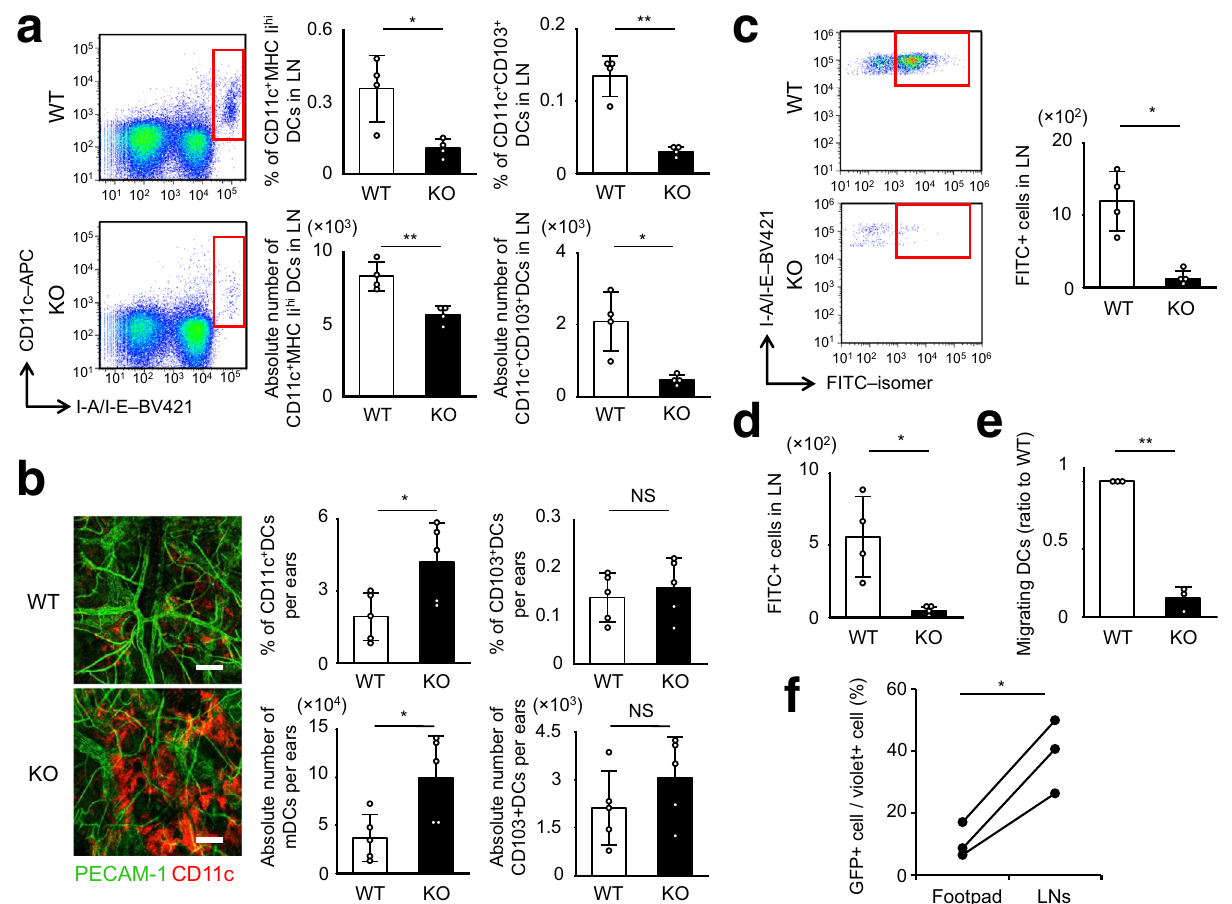
Fig. 8 Impaired in vivo DC traf fi cking in DC-speci fi c Lamtor1 − / − mice. a Migratory DC subset in inguinal LNs. Single-cell suspension from inguinal LNs was stained for CD11c and MHC II, and migratory DCs (red rectangle) were counted by fl ow cytometry (left). Population (upper) and absolute number (lower) of CD11c + MHC II hi DCs (middle), and CD11c + CD103 + DCs (right) of WT (white bar) and CD11c – Lamtor1 fl ox/ fl ox (black bar) mice are shown. b Dermal DCs in the ears. Ears from WT (upper) and CD11c – Lamtor1 fl ox/ fl ox (lower) mice were split, fi xed in 4% paraformaldehyde, stained with anti- PECAM (green) and anti-CD11c (Red), and observed by confocal microscopy. Scale bar, 100 μ m (left). Percentage (upper) and absolute number (lower) of CD45 + CD11c + dermal DCs (middle) and CD11c + CD103 + dermal DCs (right) in WT (white bar) and CD11c – Lamtor1 fl ox/ fl ox (black bar) ears, as determined by fl ow cytometry (right). c The number of fl uorescein isothiocyanate (FITC)-positive DCs in draining LNs in WT (white bar) and CD11c – Lamtor1 fl ox/ fl ox (black bar) mice. Forty-eight hours after FITC-sensitization on the ear, cells isolated from cervical LNs were stained for CD11c and MHC II. FITC + DCs were evaluated by FACS (red rectangle, left) and counted (right). d Number of FITC-bead – bearing DCs in popliteal LNs. Forty-eight hours after FITC-bead injection into the footpads of WT (white bar) and CD11c – Lamtor1 fl ox/ fl ox (black bar) mice, cells were isolated from popliteal LNs, stained for CD11c and MHC II, and analyzed by FACS. FITC + DCs were counted. e Comparison of DCs arriving in LNs after footpad administration. CFSE-labeled WT (white bar) and Lamtor1 − / − (black bar) DCs were adoptively injected into the right and left footpads of WT recipient mice, respectively. Single cells were isolated from popliteal LNs 48 h after injection, and CFSE + cells were counted. The ratio of the number of fl uorescein-labeled DCs was calculated relative to WT. f In vivo DC-traf fi cking of Lamtor1 − / − DCs in which Lamtor1 expression was restored. Lamtor1 -IRES-GFP vector was introduced into Lamtor1 − / − BMDCs using a lentivirus system, and the cells were stained with cell tracer violet. The violet-labeled DCs were injected into the footpad of WT mice, and cells were isolated from popliteal LNs. The ratio of GFP + DCs (Lamtor1-restored DCs) to violet + DCs (lentivirus-treated DCs including Lamtor1-restored and -not restored DCs) in popliteal LNs was determined by FACS. Data were pooled from four ( a – d ) or three ( e , f ) independent experiments. Statistical analysis was performed by two-sided Student ’ s t -test ( a – e ) [means ± s.d.; * p < 0.05, ** p < 0.01] and by two-sided paired sample t -test ( f ) [ * p <